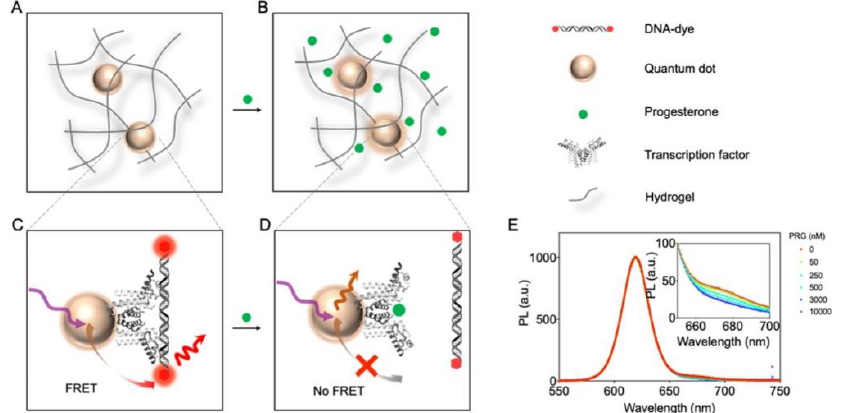
Figure 4. QD-based FRET sensor immobilized in the hydrogel. ( A , B ) Schematic illustration of progesterone diffusion into the hydrogel. ( C , D ) FRET-based sensor utilizing the TF–DNA binding mechanism. When progesterone (PRG) binds to the TF, the affinity between the TF and DNA reduces. The resulting dissociation of the TF–DNA complex produces a decreased FRET signal. ( E ) Representative spectra of sensor response to progesterone. A selection of the analyte concentrations is plotted for visual clarity. A zoomed-in figure is shown in the inset (Reprinted with permission from [57]. Copyright 2022 American Chemical